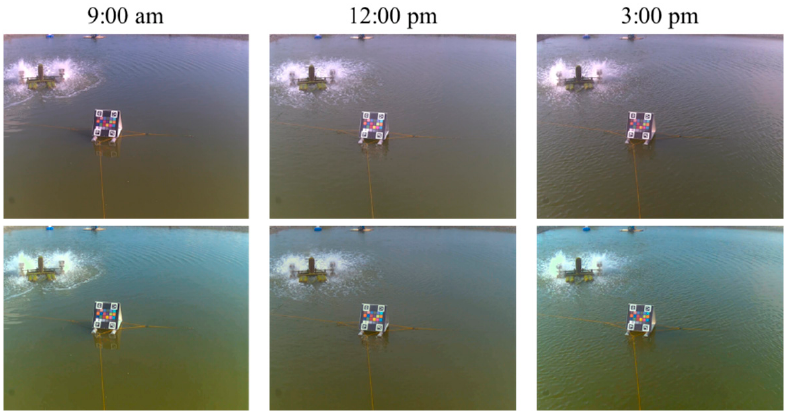
Figure 12. Results of color correction on site: original images (upper), and the color-corrected images (bottom).